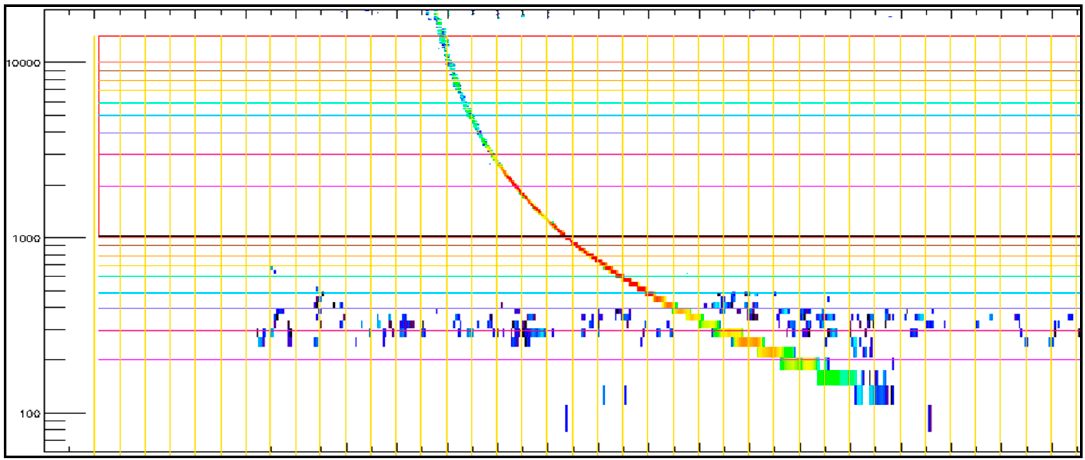
Figure 6. The segmentation of an input image of a 4-s duration observation into a grid line to extract the corresponding information. 294